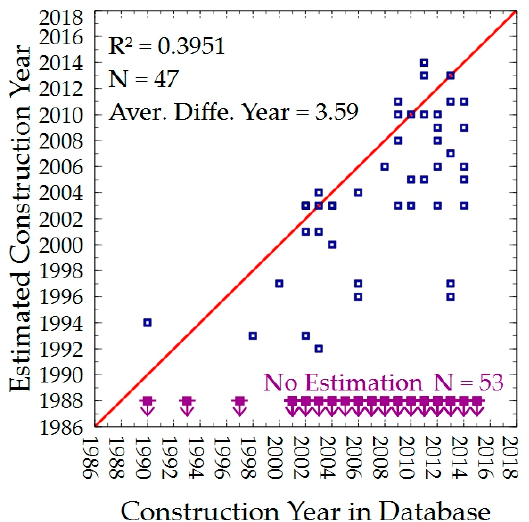
Figure 26. Comparison of the database and estimated years of construction of the 100 medium bridges. The plotted points are not very far from the red line, which indicates good accuracy.